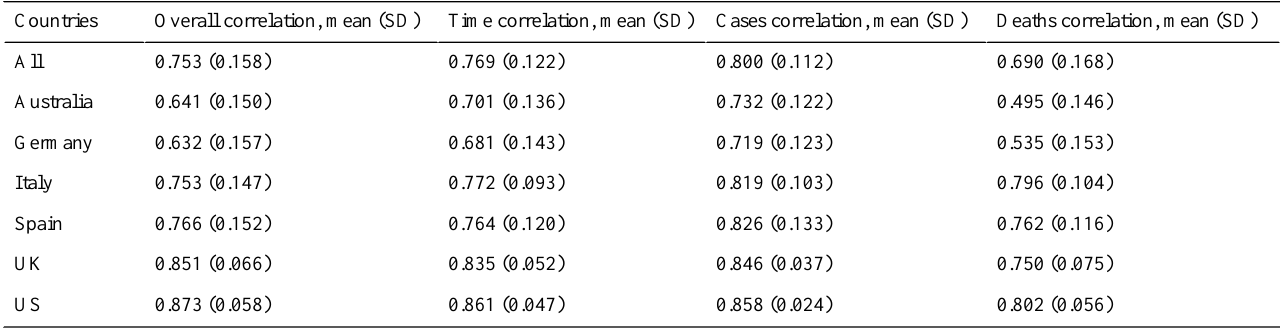
Table 1. Mean Spearman rho rank coefficients and their standard deviations are given for each country and overall results for all six countries.